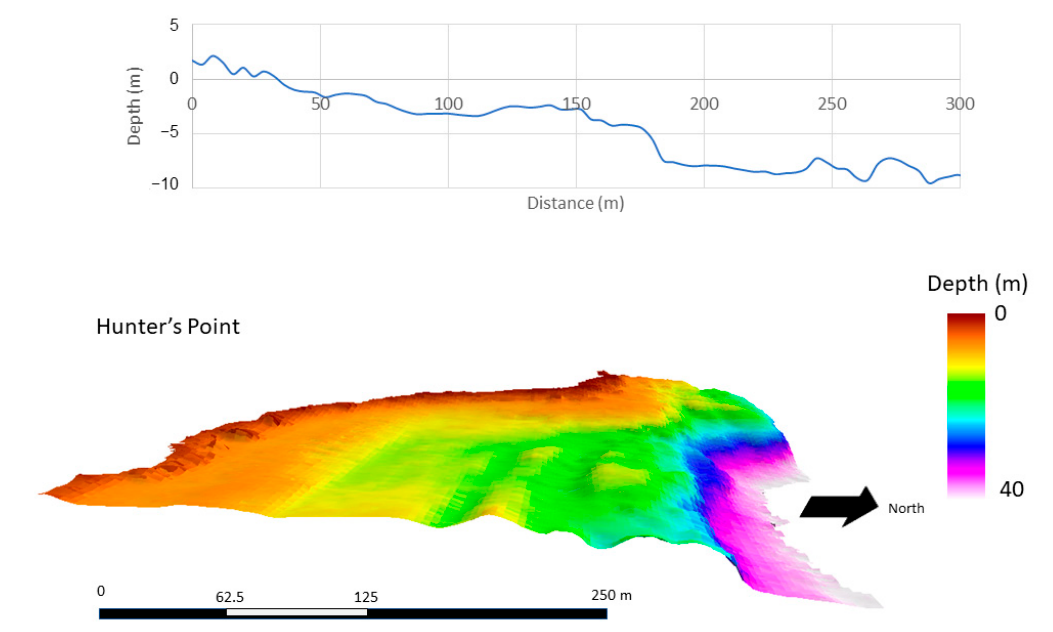
Figure 7. Average bathymetric profile of three 300-m transects ( top ), and area bathymetry (4-m resolution) of Lake Superior ( bottom ) at Hunter’s Point park.